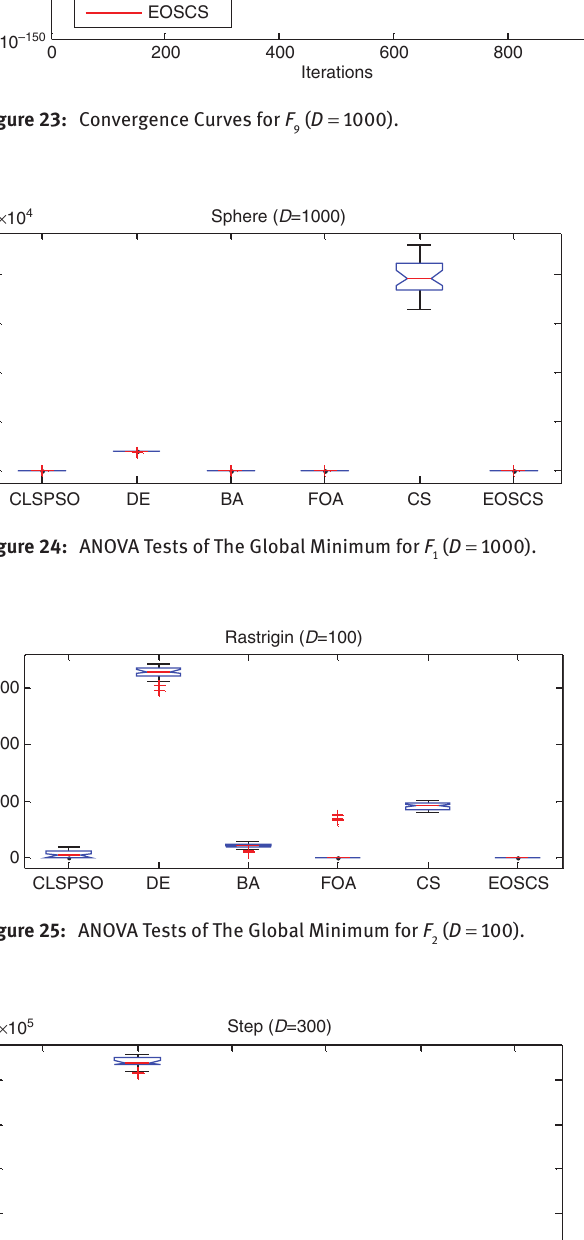
Figure 26: ANOVA Tests of The Global Minimum for F